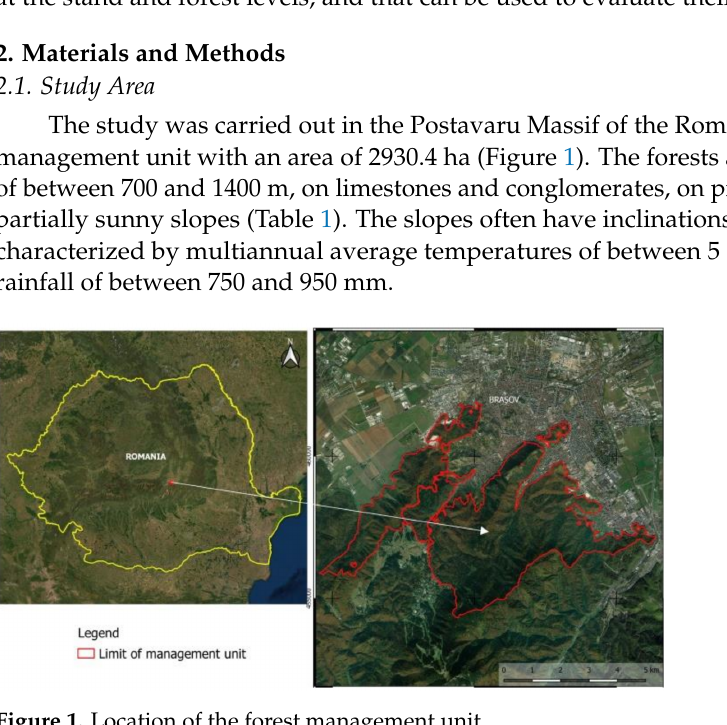
Figure 1. Location of the forest management